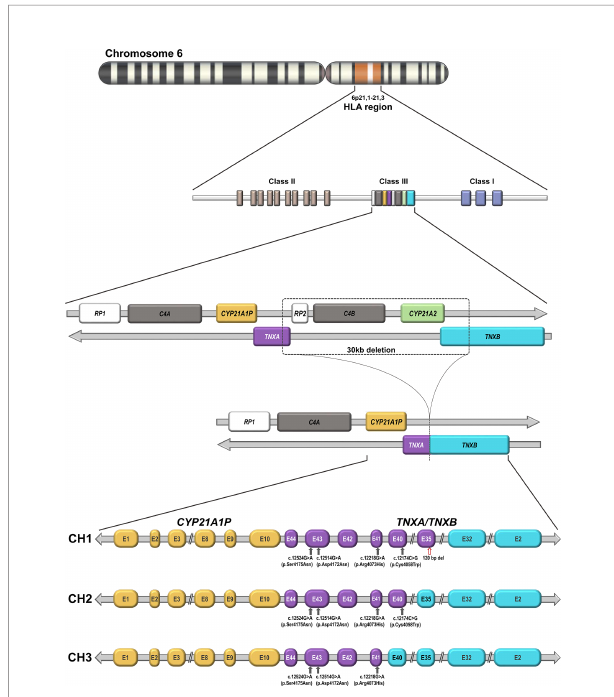
FIGURE 1 | Genomic organization of the CYP21 locus on chromosome 6p21.1-21.3: The functional CYP21A2 gene and its non-functional CYP21A1P pseudogene are arranged in tandem repeat with the two C4 genes that encode factor four of the complement system, the serine